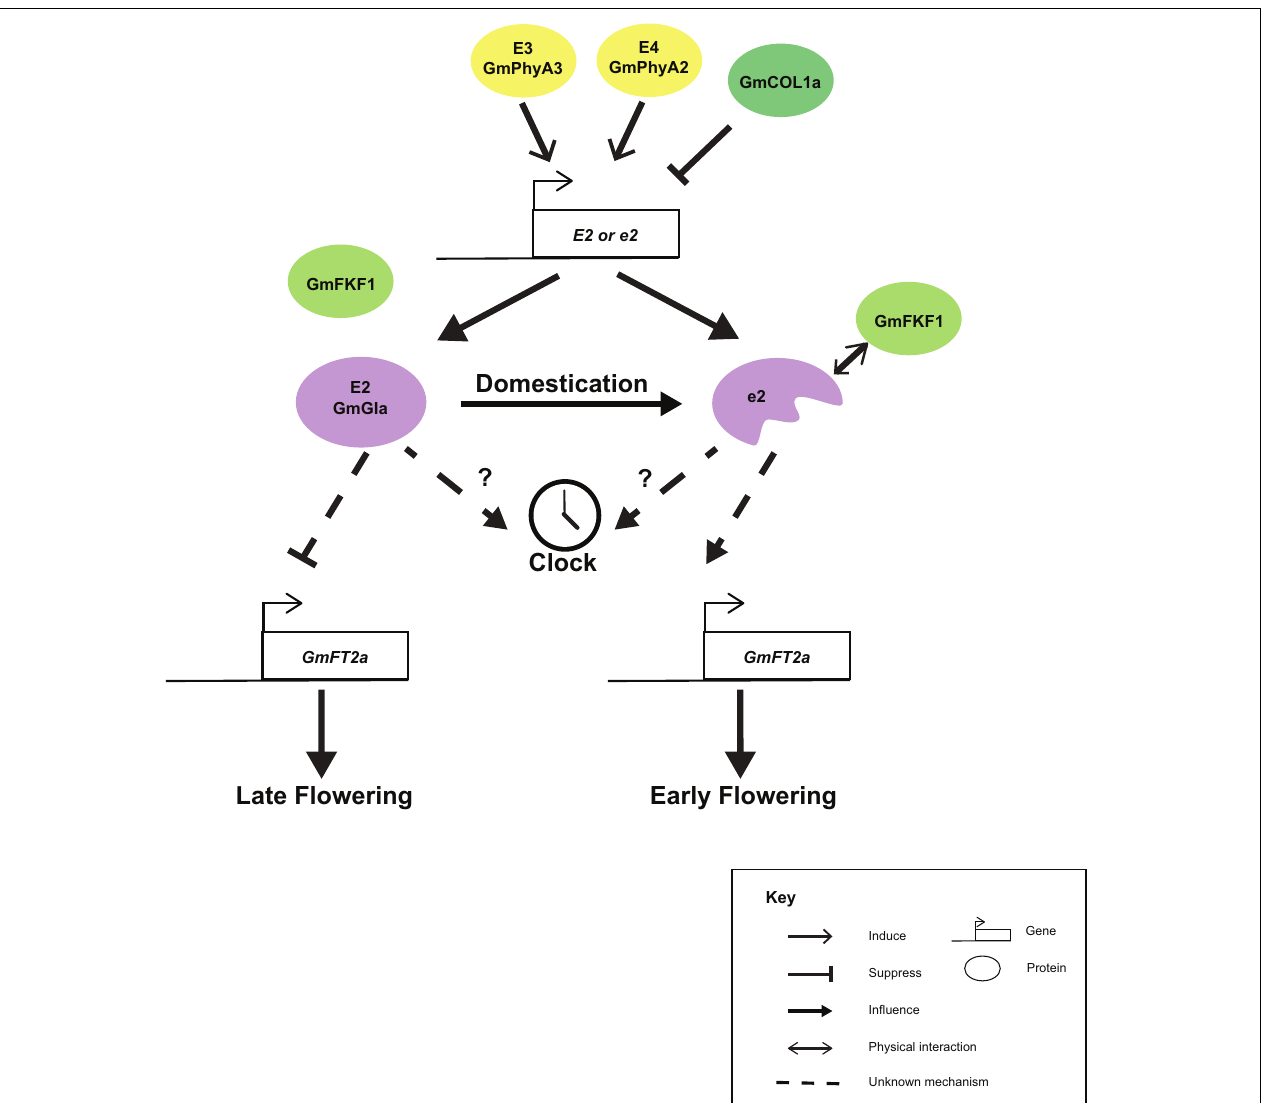
FIGURE 3 | Cartoon summarizing the known interactions of GmGIa . Expression of GmGIa ( E2 ) is controlled by E3 , E4 loci and GmCOL1a. During domestication, a truncated GmGIa gene ( e2 ) was selected. The truncated protein but not the full-length protein can interact with GmFKF1 in yeast 2 hybrid assay. The full-length GmGIa (E2) protein can suppress the expression of GmFT2a and leading late flowering phenotype. In the opposite, GmFT2a is derepressed in e2 background allowing early flowering phenotype.